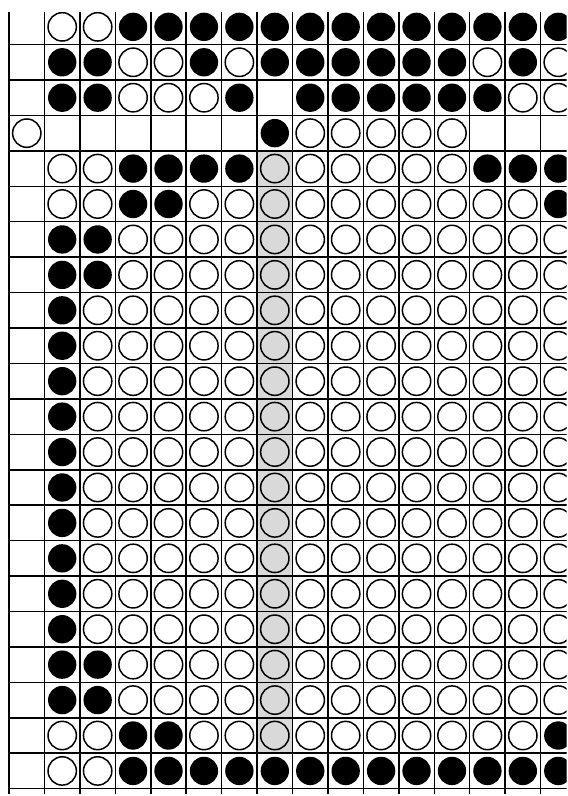
Figure 86. BLACK wins.